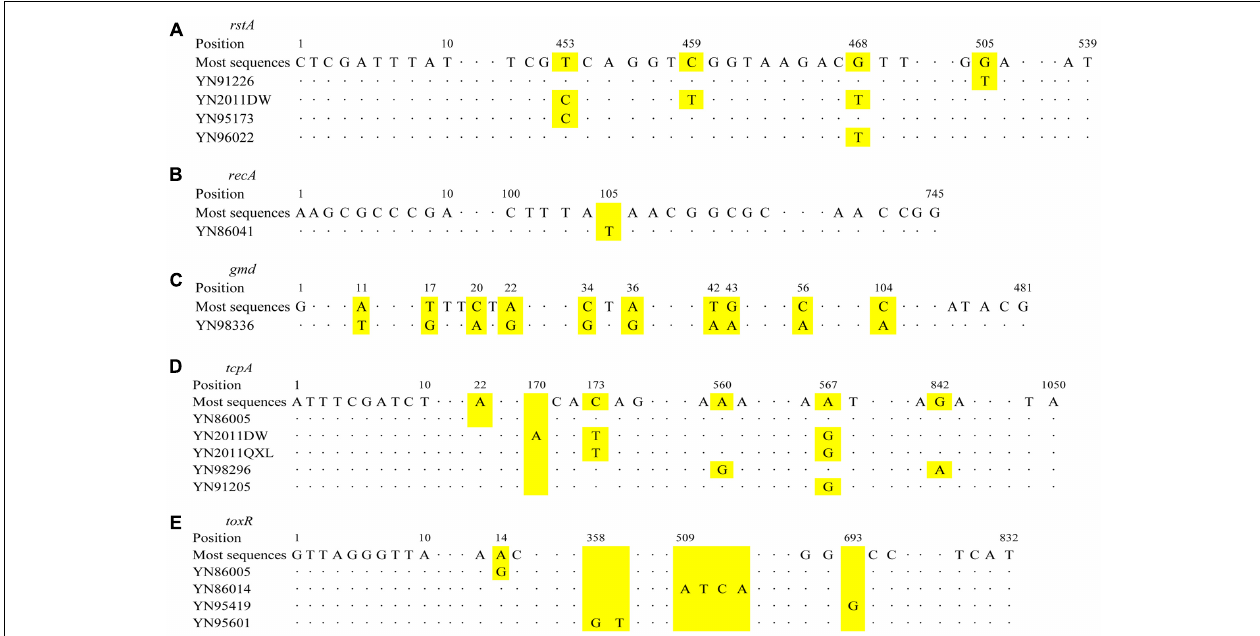
FIGURE 3 | Schematic diagram of base position changes for different genes. (A) rstA ; (B) recA ; (C) gmd ; (D) tcpA ; and (E) toxR . The yellow areas for each gene represent the changes of base